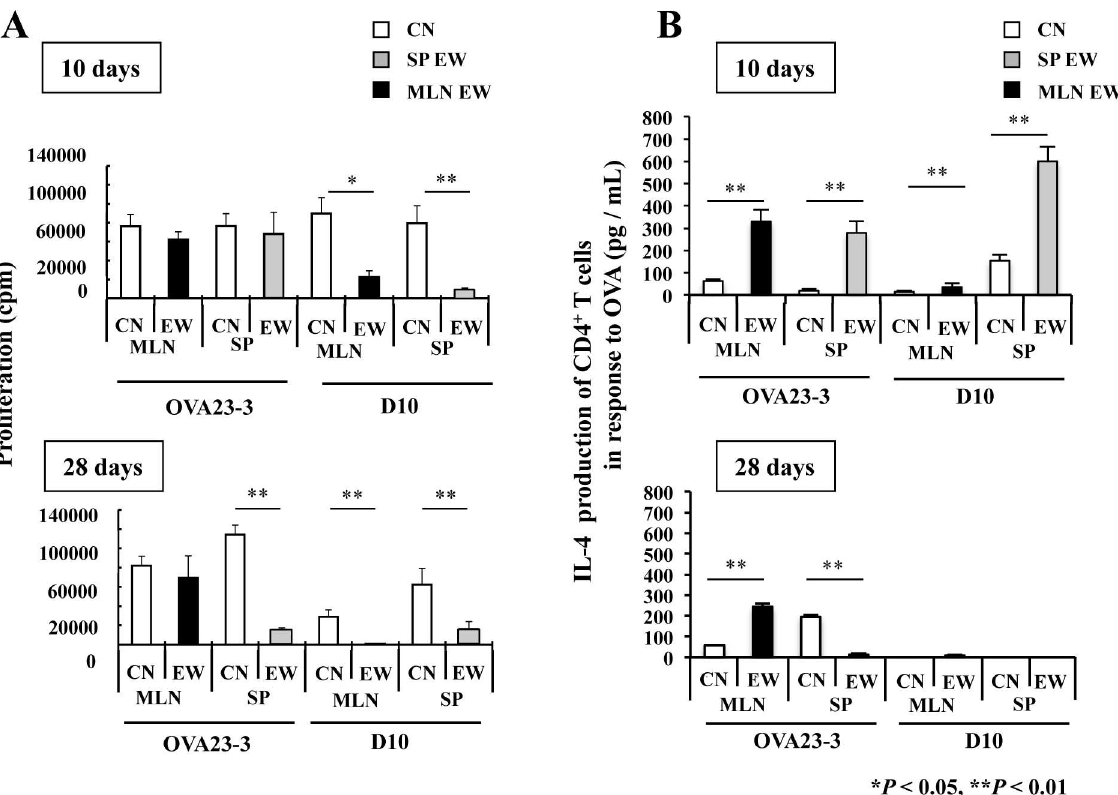
Fig 3. Responses of systemicor intestinal OVA-specific CD4 + T cells from EW-fed OVA23-3 and D10 mice. Proliferation and IL-4 production of OVA-specific CD4 + T cells purifiedfrom spleen(SP) or mesenteric lymph nodes(MLNs) of control-diet-fed (CN, n = 3) or EW-fed (n = 2 or 3) OVA23-3 or D10 mice (n = 3 or 4). A, Proliferation of OVA-specific CD4 + T cells on day 10 (upper panel) and day 28 (lower panel)of EW diet. B, IL-4 production of OVA-specific CD4 + T cells on day 10 (upper panel)and day 28 (lower panel)of EW diet. The CD4 + T-cell responses from the MLN (black bars) and spleen(SP; gray bars) of EW-fed mice and control- diet-fed mice (white bars) are shown. These results are representative of three independent experiments; * , P < 0.05; ** , P < 0.01.